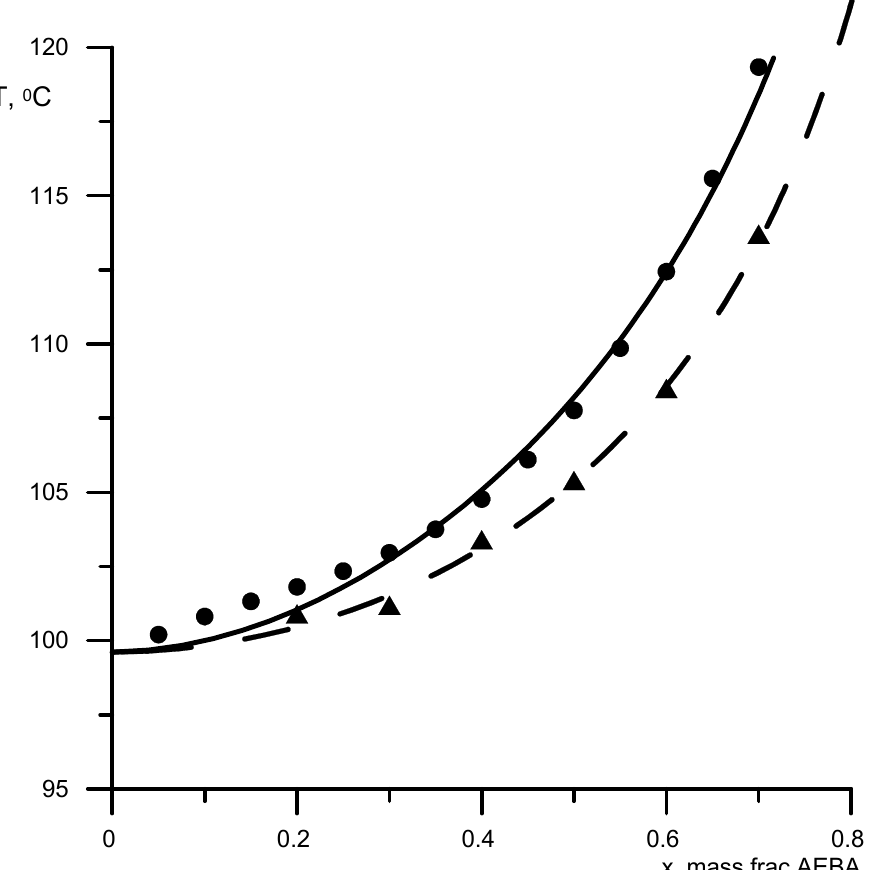
Figure 3. Boiling points of aqueous AEBA solutions at atmospheric pressure. Geometric figures are experimental values (circles—AEBA-diethylene glycol (DEG); triangles—AEBA-TEG), and lines are calculated values.